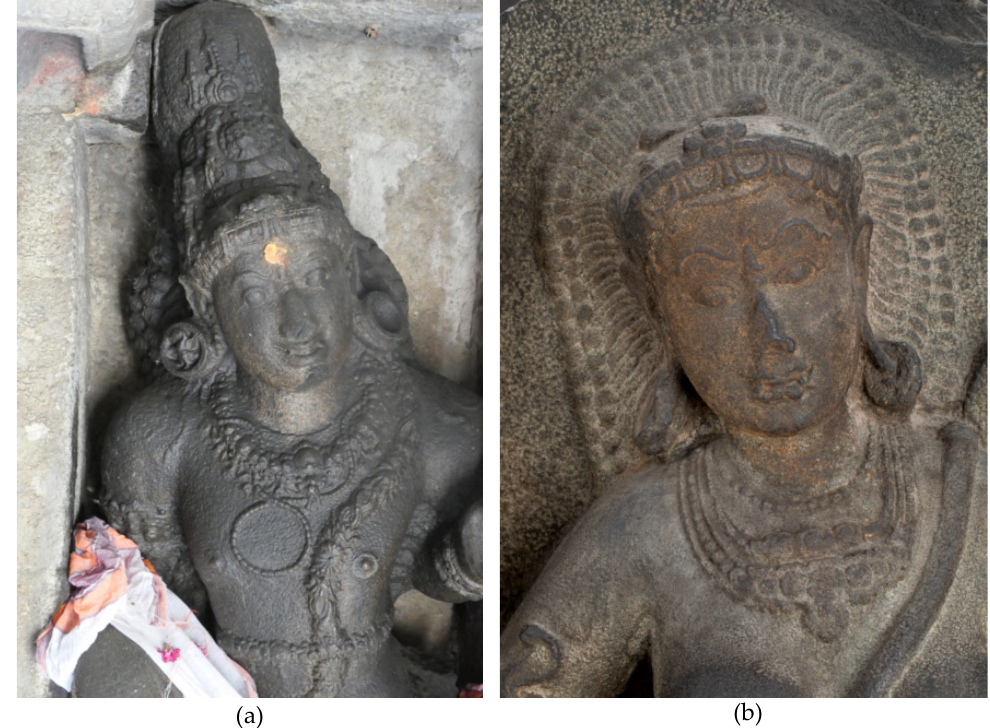
Figure 9. ( a ) Door guardian, Agasty ēś vara temple, Kilaiyur-Melappallavur, Tamil Nadu, late 9th century. Photograph by Katherine E. Kasdorf. ( b ) Detail of Yogini in Figure 1.